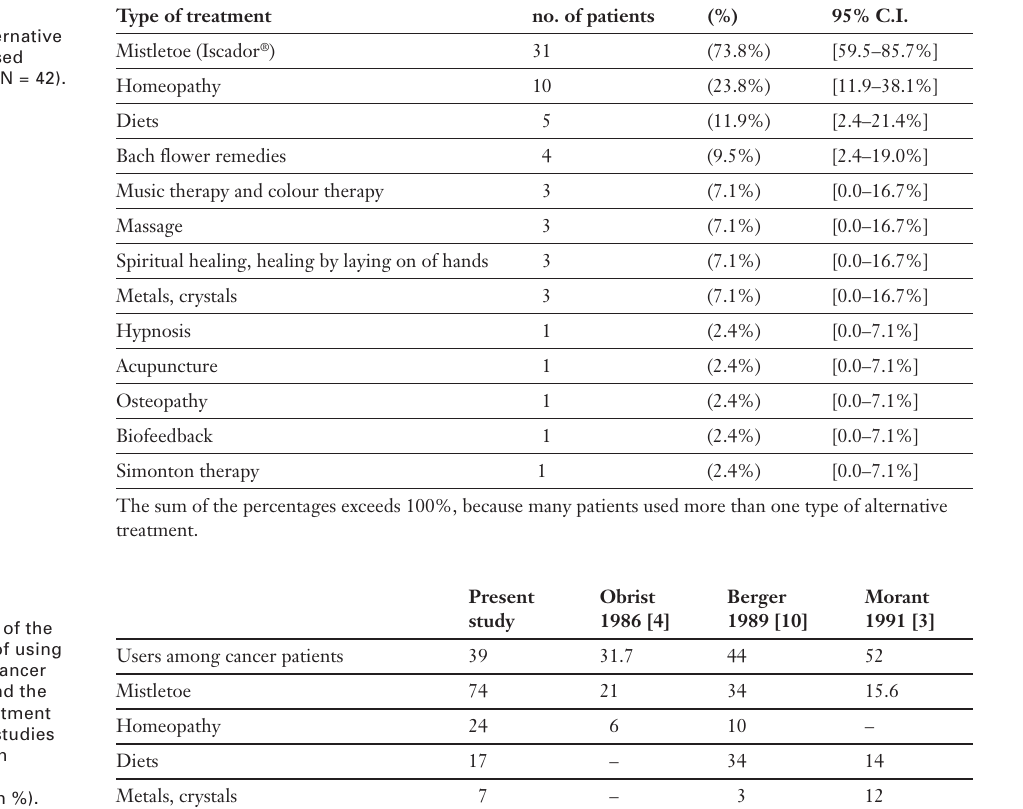
Table 2 Types of alternative treatment used by patients (N = 42).